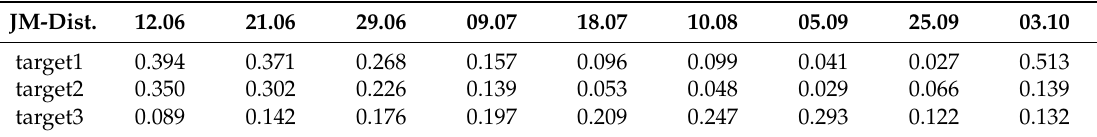
Table 5. The Jeffries-Matusita (JM)-distance values between the reference spectrum and target spectra during the growth period.